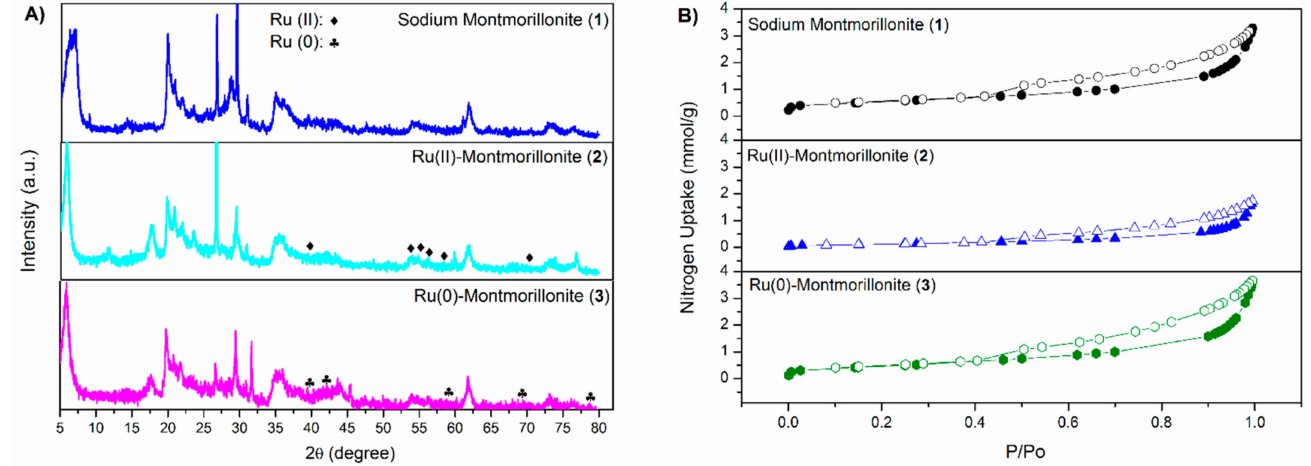
Figure 2. XRD pattern ( A ) and BET isotherm ( B ) of sodium montmorillonite 1 and ruthenium containing montmorillonite 2 and 3